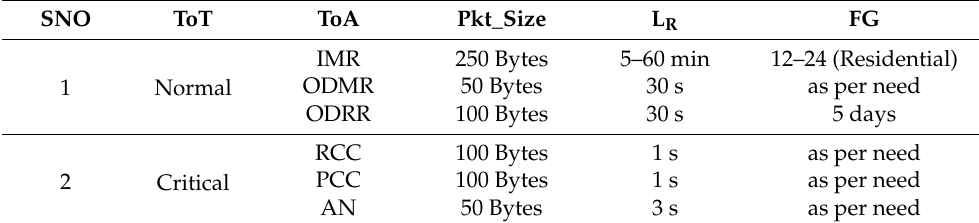
Table 2. Classification of AMI traffic types and their characteristics in